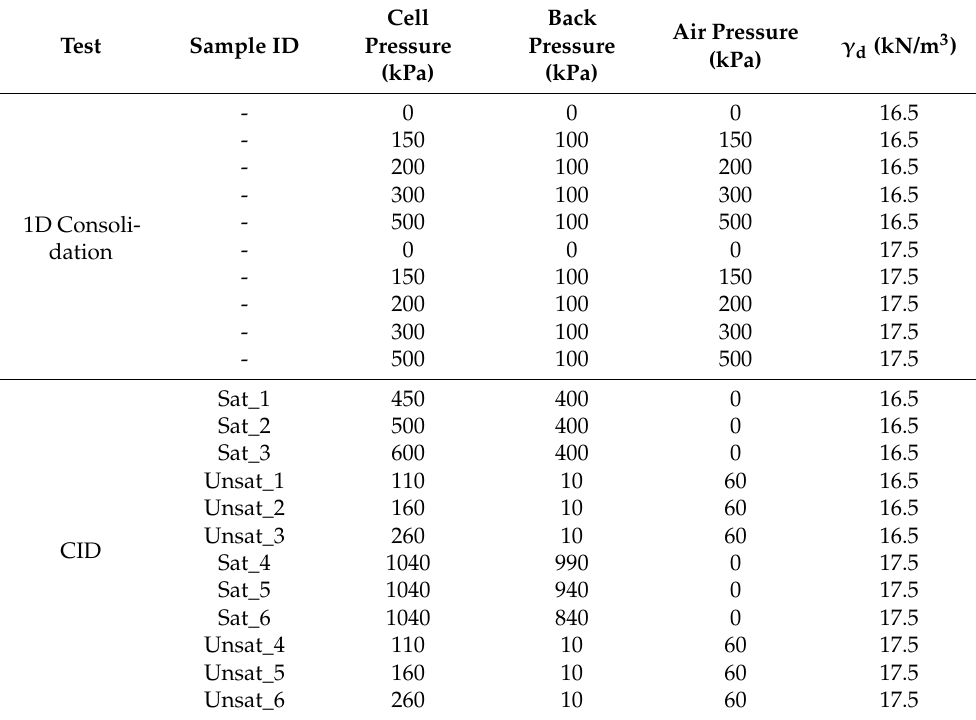
Figure 8. Variations in weight relative to test duration and salts used for each density. Table 5. Tests carried out under saturated and unsaturated